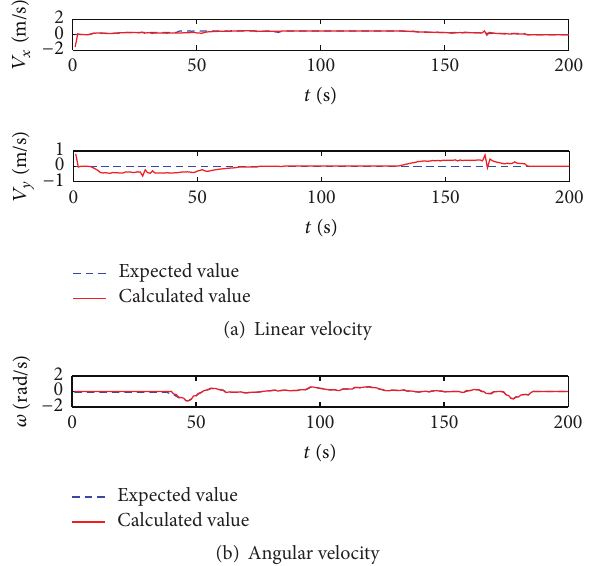
Figure 12: Comparisons between the expected angular velocity and calculated